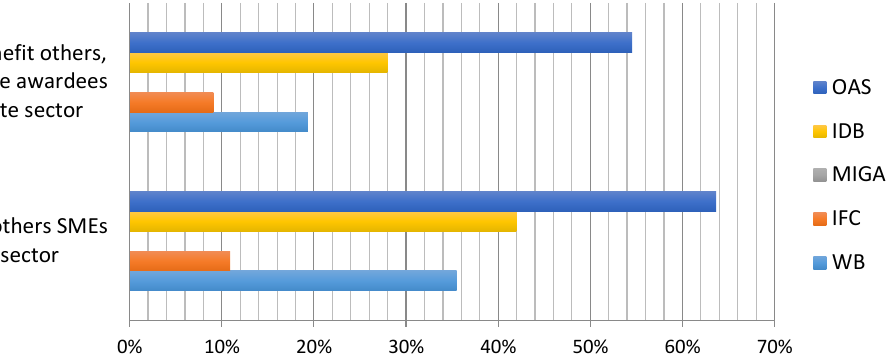
by organizations (indicators B4 and B5)